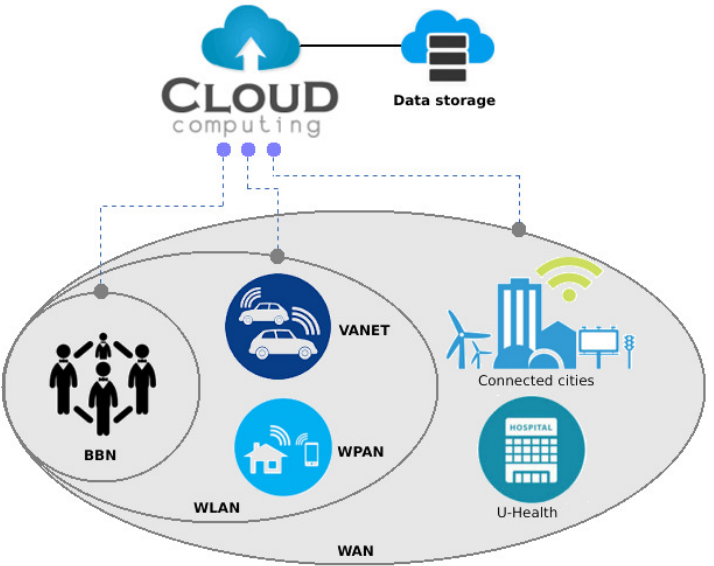
Figure 8. Internet of things (IoT) landscape including body-to-body